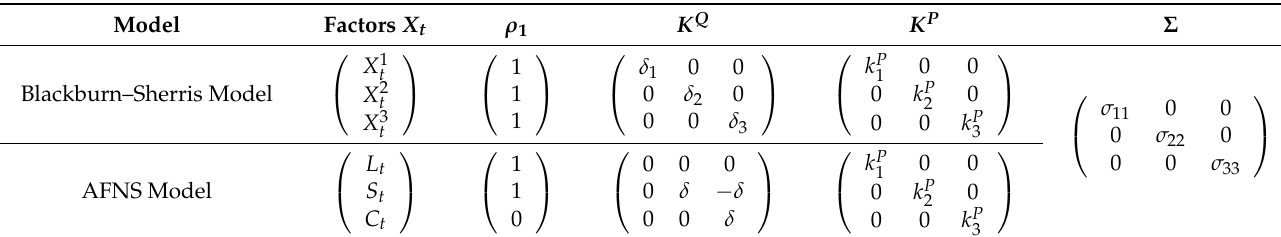
Table 1. Affine Mortality Models—Independent Factor Model